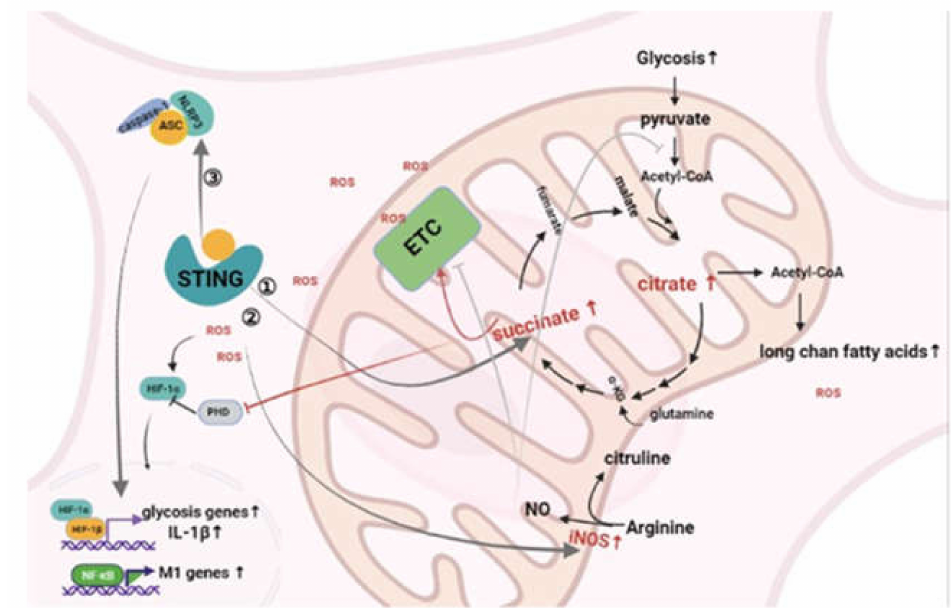
Figure 3. STING-centered inflammation pathway changes the metabolism of